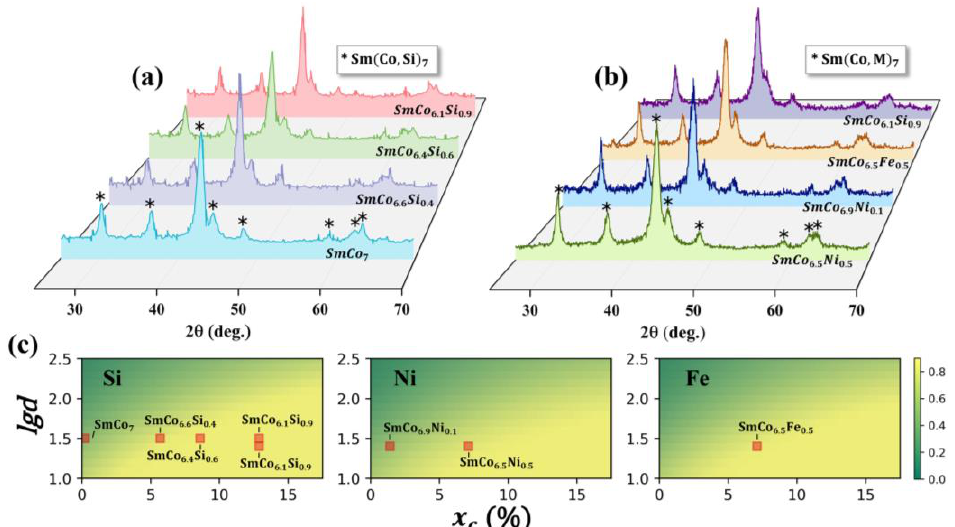
Figure 8. Experimental verification for doping elements that can stabilize the 1:7 H single phase obtained by ML . The asterisk represents the peak of the 1:7 H phase measured by XRD: ( a ) Phase analysis for SmCo 7−x Si x (x = 0, 0.4, 0.6, 0.9), and the mean grain size is 28 – 44 nm [21]; ( b ) Phase analysis for SmCo 6.5 Ni 0.5 , SmCo 6.9 Ni 0.1 , SmCo 6.5 Fe 0.5 , and SmCo 6.1 Si 0.9 , and the mean grain size is 25 – 30 nm; ( c ) Comparison of experimental results and ML predictions of SmCo 7−x M x (M = Si, Ni, Fe) alloys.